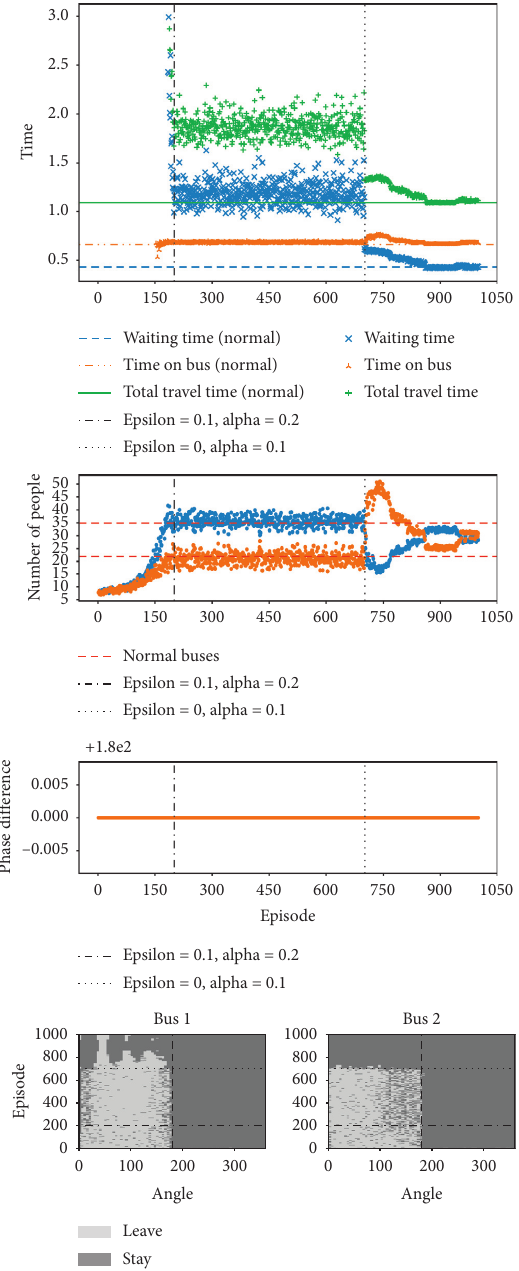
Figure 5: Two buses with frequency detuning serving a loop of bus stops during a lull period do not learn the expected no-boarding strategy by reinforcement